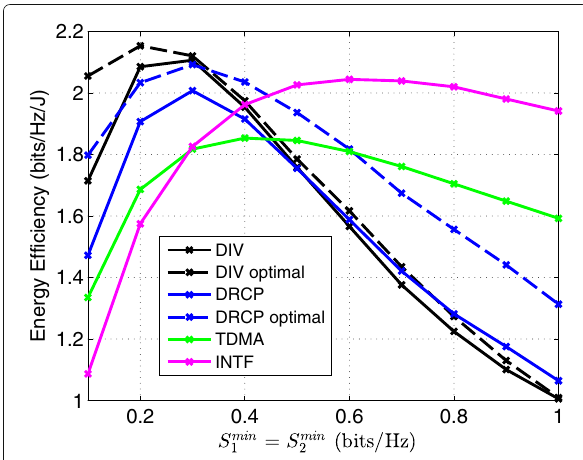
Fig. 11 Energy efficiency of the studied approaches in the circuit power-dominated regime with equal average links